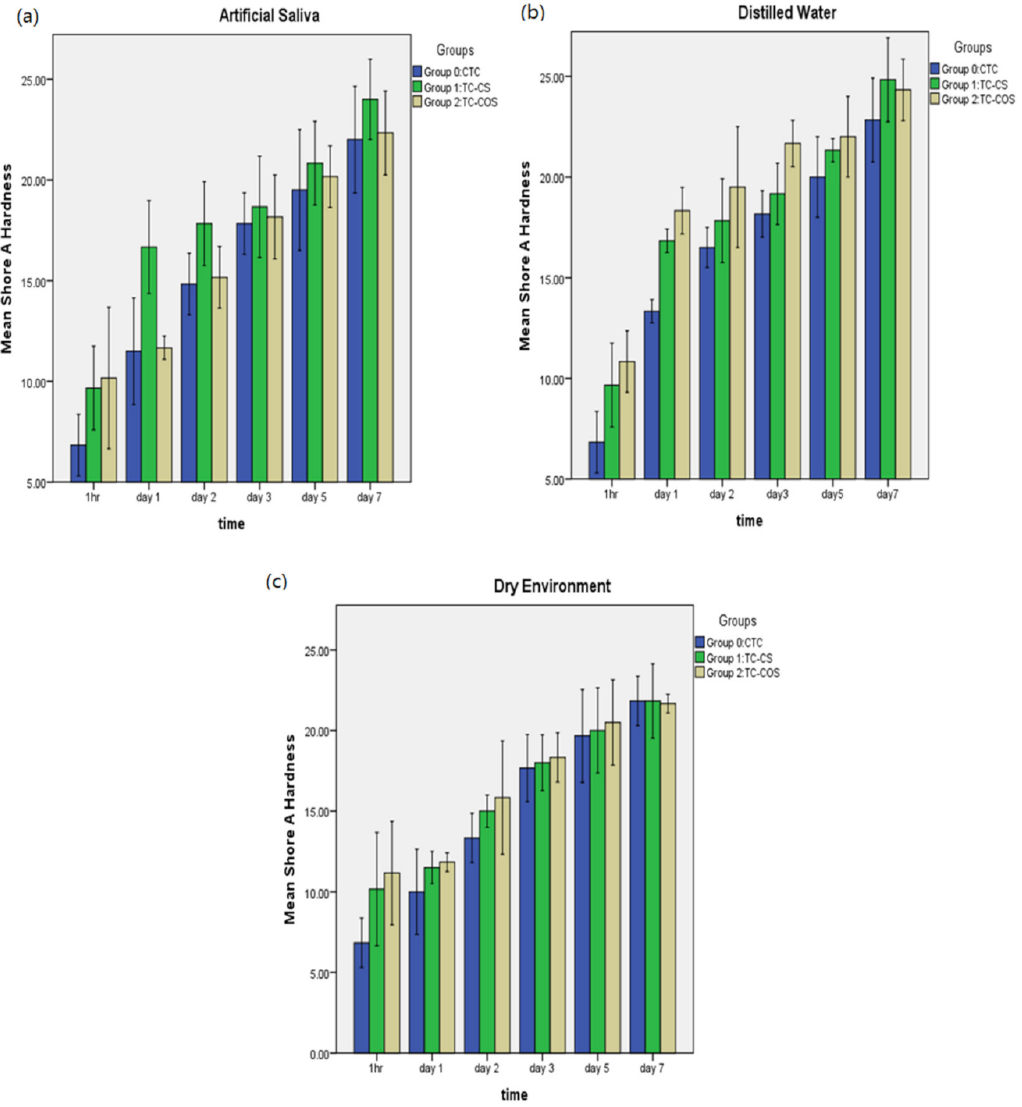
Figure 3. Mean Shore A hardness of tested material upon aging in various environment; ( a ): artificial saliva, ( b ): distilled water, ( c ): dry